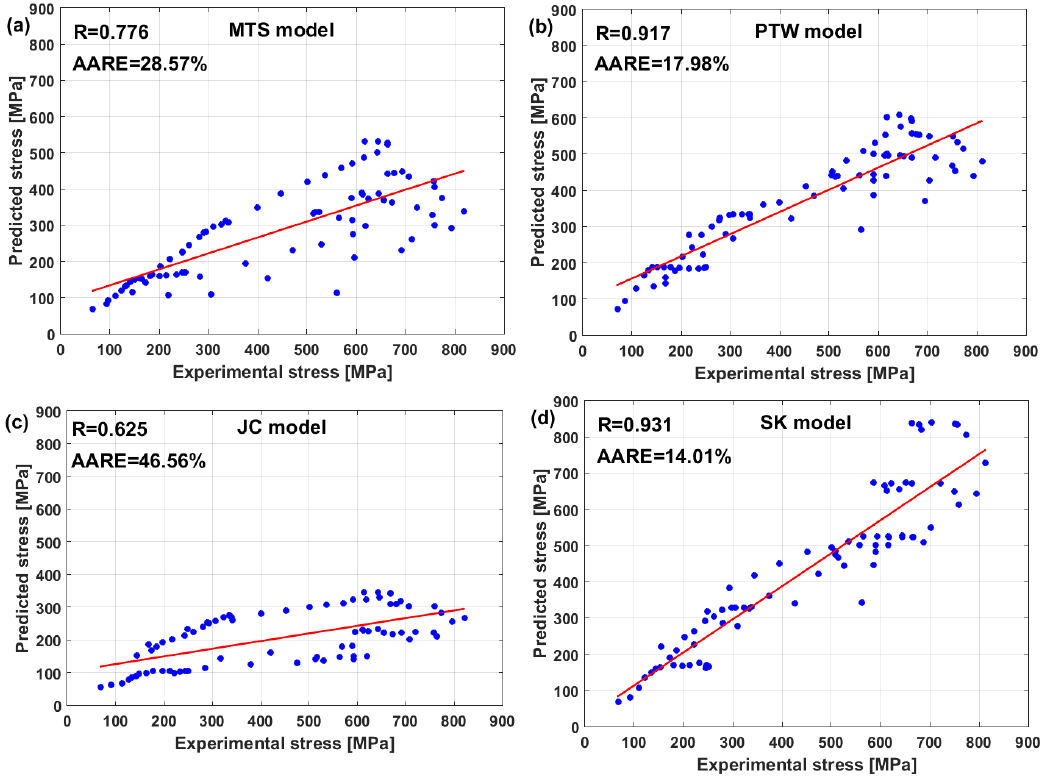
Figure 19. Correlation of experimental stresses and predicted stresses for copper at temperatures of 571 K – 1096 K and strain rates of 4000 s − 1 – 693,000 s −1 obtained by ( a ) the MTS model ( b ), PTW model 571–1096 K and strain rates of 4000–693,000 s − 1 obtained by ( a ) the MTS model ( b ), PTW model ( c ), ( c ), JC model, and ( d ) SK model. JC model, and ( d ) SK